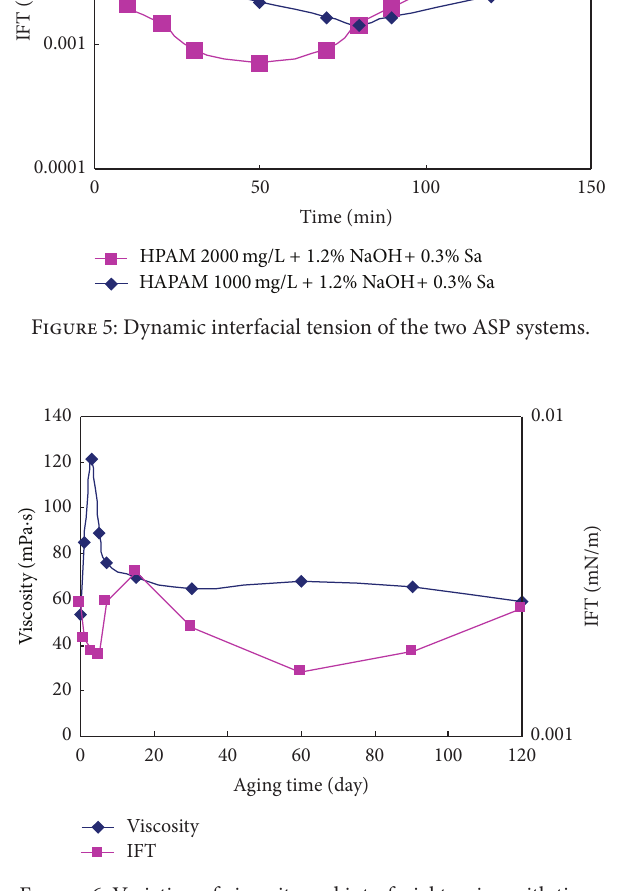
Figure 6: Variation of viscosity and interfacial tension with time.